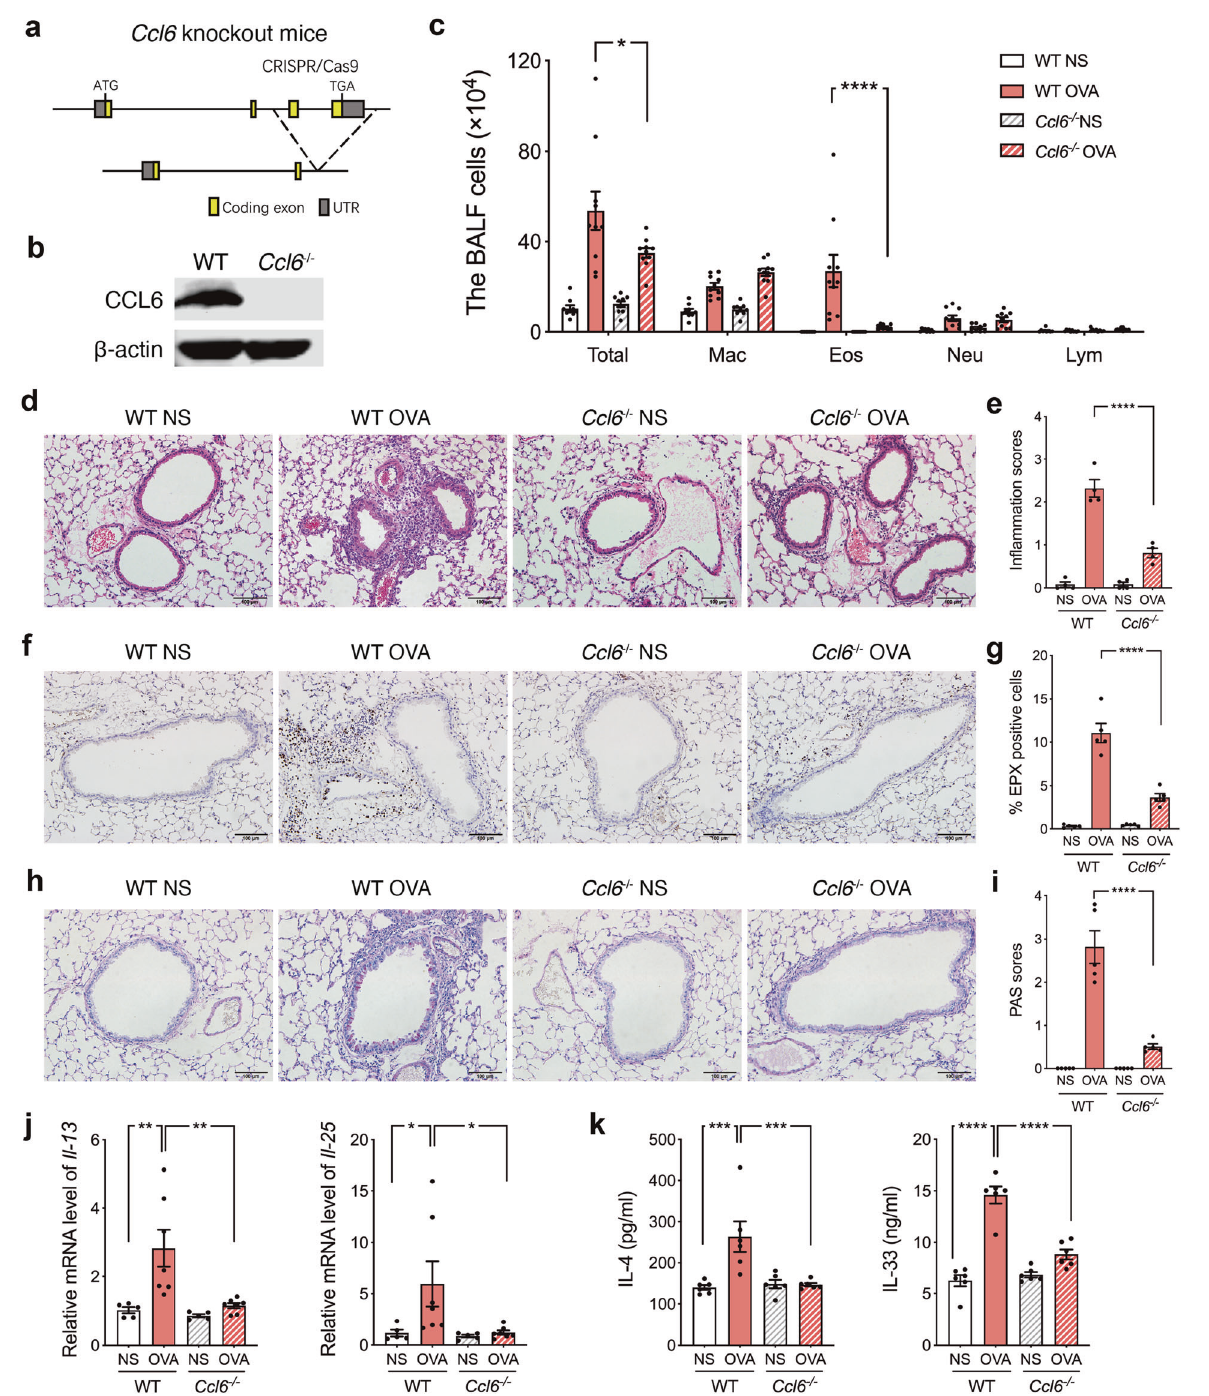
Fig. 3 CCL6 de fi ciency alleviates OVA-induced eosinophilic airway in fl ammation. a Schematic map of established Ccl6 − / − mice by using the CRISPR/Cas9 system. b Representative blots of mCCL6 and β -actin (loading control) assessed by Western blot of protein extracts of eosinophils sorted from WT and Ccl6 − / − mice. c Differential counts on Wright-Giemsa stained BALF cells in WT and Ccl6 − / − mice. OVA-induced asthma model was presented in Fig. 1a. Combined data shown as mean ± SEM are presented for 9 – 10 mice per group from two independent experiments. Representative photomicrographs of lung sections with H&E staining ( d ), EPX staining ( f ), and those with PAS staining ( h ) at 24 h after the last OVA challenge. Scale bar, 100 μ m. Histological in fl ammatory scores ( e ) and PAS scores ( i ) were analyzed from d and h . g The quantitative percentages of EPX + cells in total nucleated cells analyzed from f ( n = 4 – 5 mice per group, 4 images per mouse). j Relative mRNA levels of Il-13 and Il-25 in lung tissues were determined by quantitative RT-PCR at 24 h after the last NS or OVA challenge. k The concentration of IL-4 and IL-33 in lung tissue determined by ELISA. Data are mean ± SEM for 4 – 5 mice per group, 5 – 7 images per mouse. * P < 0.05; ** P < 0.01; *** P < 0.001; ****, P < 0.0001 by one-way ANOVA with Sidak ’ s multiple comparisons